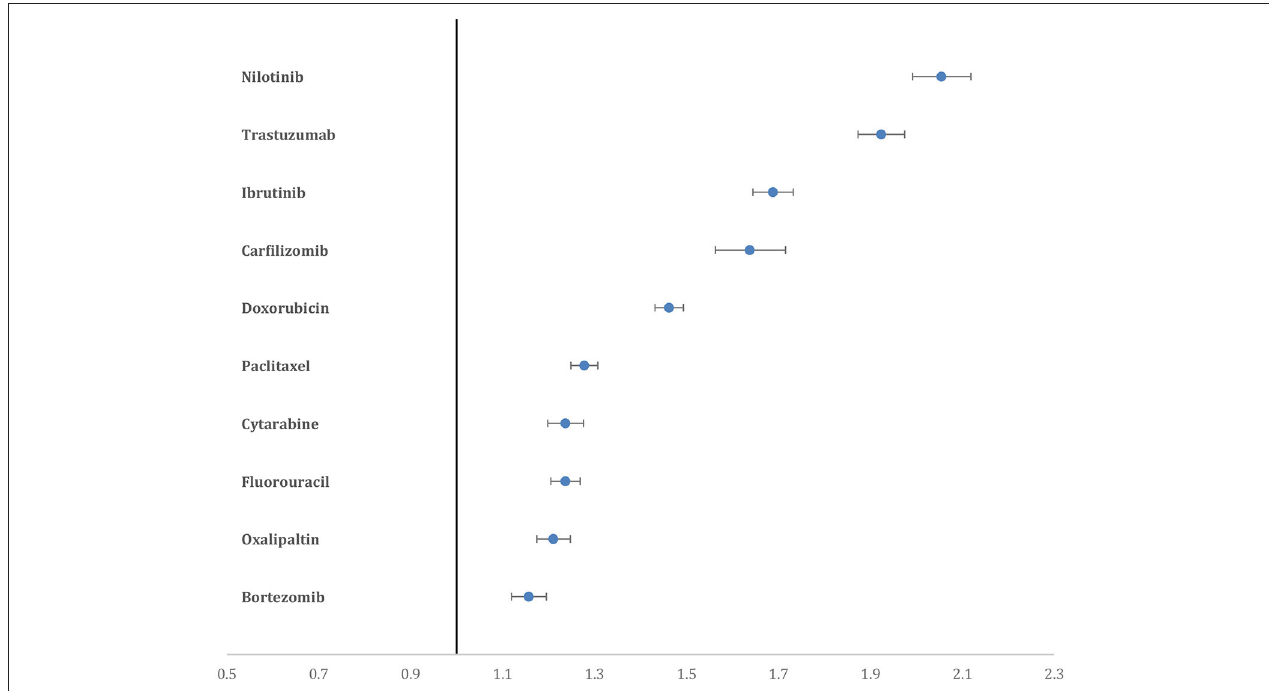
FIGURE 2 | Forest plot showing the PRR of CAE for the top 10 drugs. Nilotinib and trastuzumab have higher PRR compared to all other drugs.